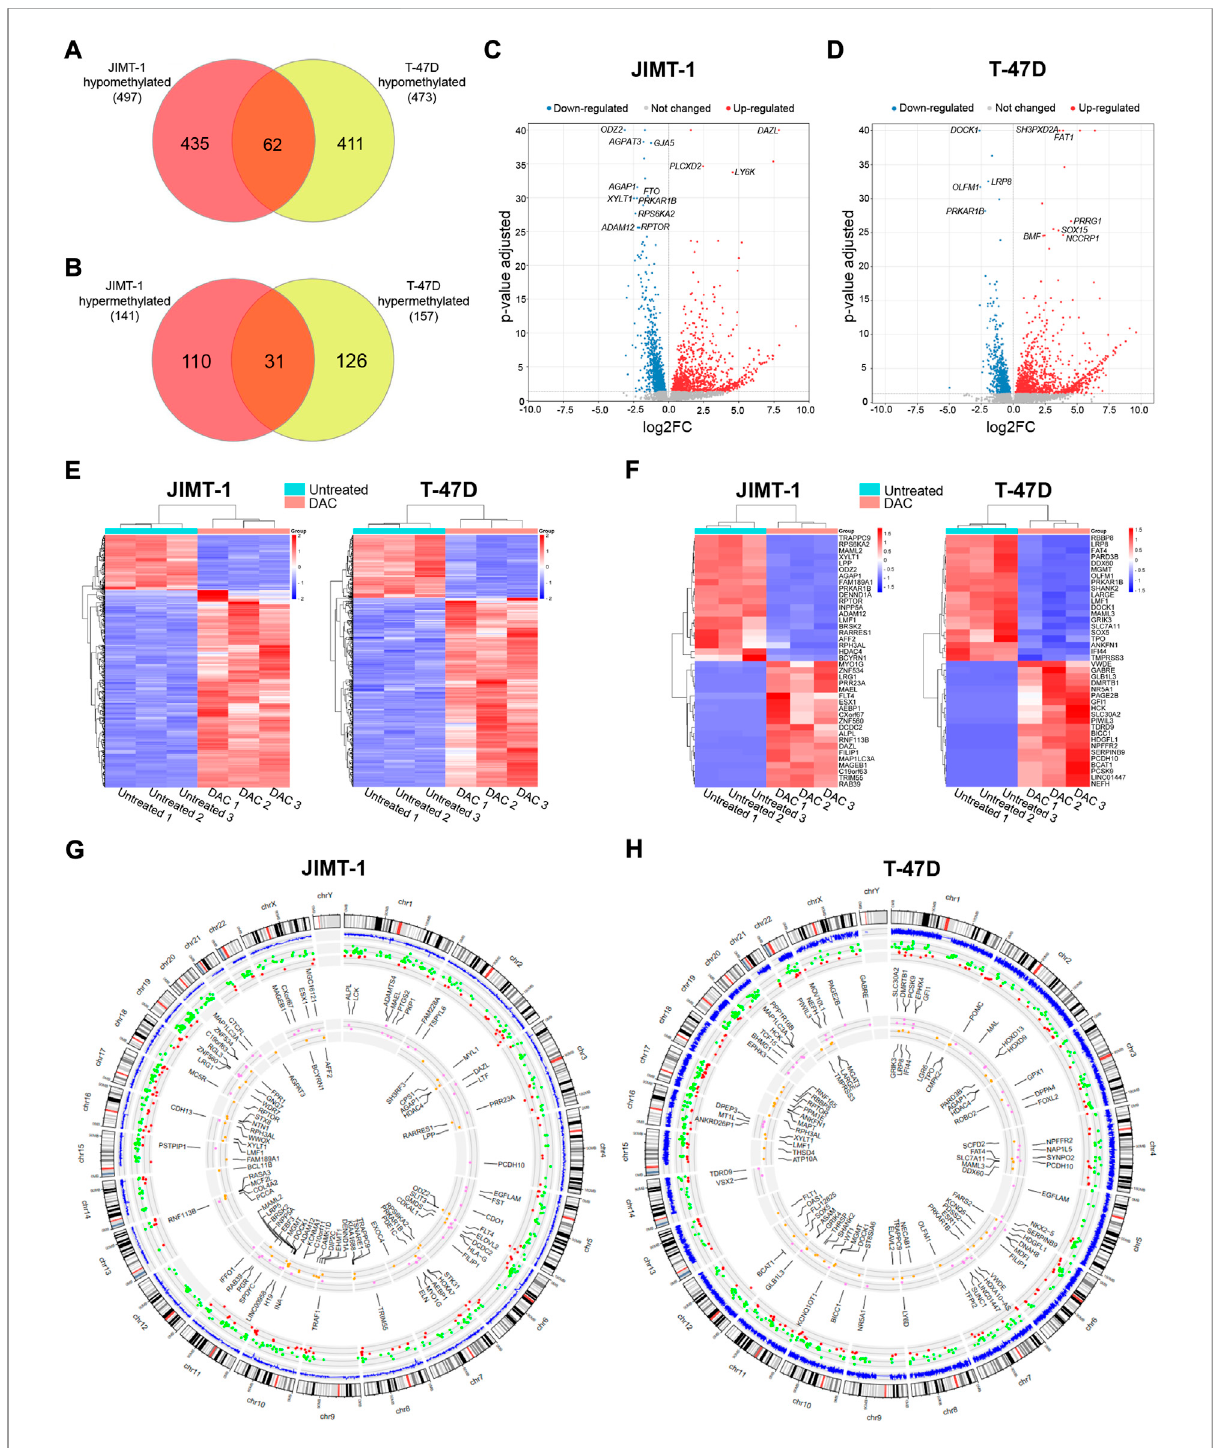
FIGURE 5 Integration of decitabine (DAC)-induced DNA methylation and gene expression changes. The number of (A) hypomethylated and (B) hypermethylatedgenesafterDACtreatmentinJIMT-1andT-47Dcelllines( p -value ≤ 0.01;abs(log2FC) ≥ 1,FDR p -value ≤ 0.5setascut-offsforDNA methylation and gene expression, respectively); Volcano scatter plots showing the distribution -log10 ( p -value) (y-axis) and log2FC (x-axis) of methylation-mediated changes in mRNA expression induced by exposure to DAC compared to non-treated controls for (C) JIMT-1 and (D) T- 47D cells. In each plot, signi fi cantly up-regulated entities are highlighted by red and down-regulated by blue. Non-signi fi cant fi ndings are presented as grey dots; Heatmaps depict (E) all DAC-induced DNA methylation-mediated gene expression changes in JIMT-1 and T-47D cells, and (F) the